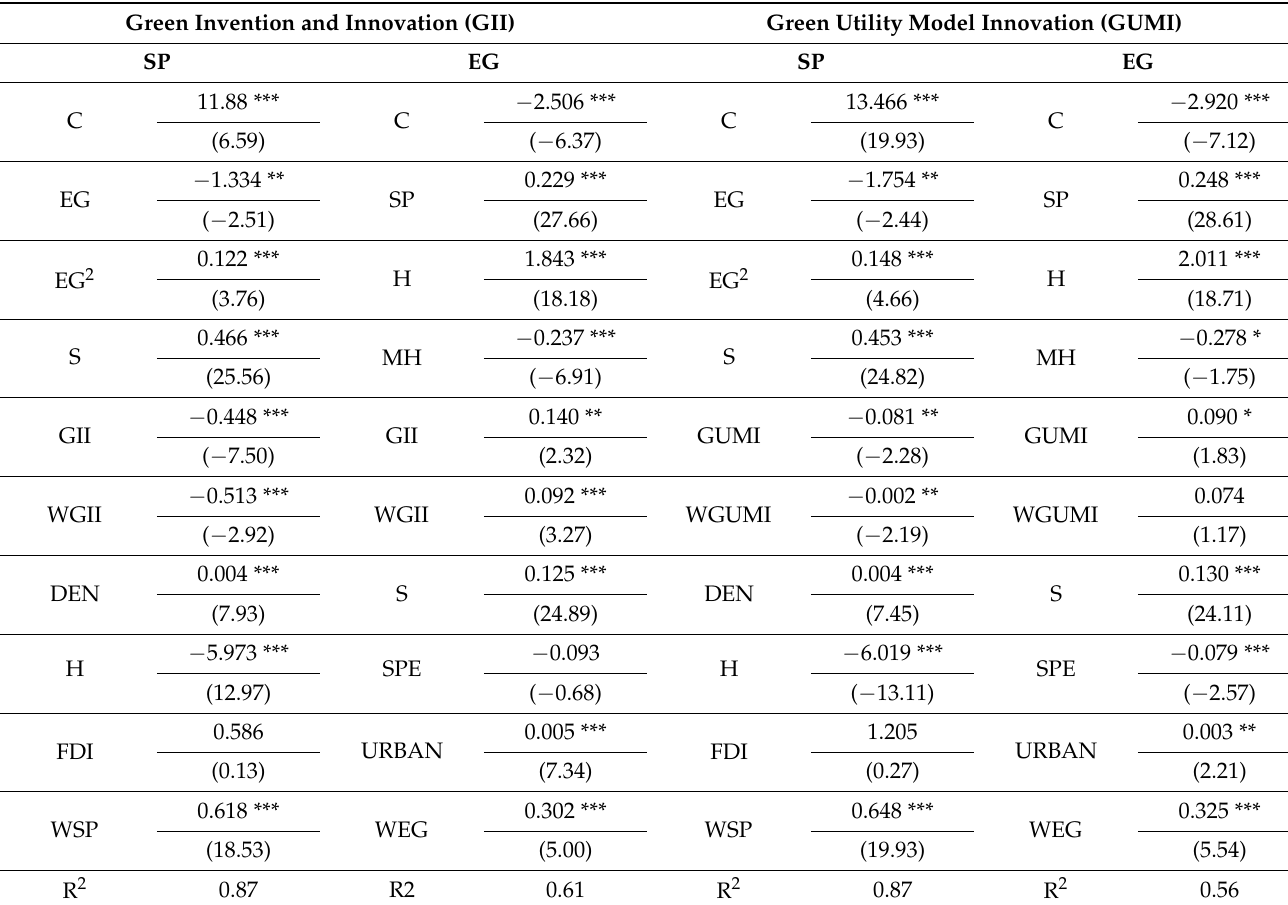
Table 5. Impacts of different types of GTI on SP and EG. Green Invention and Innovation